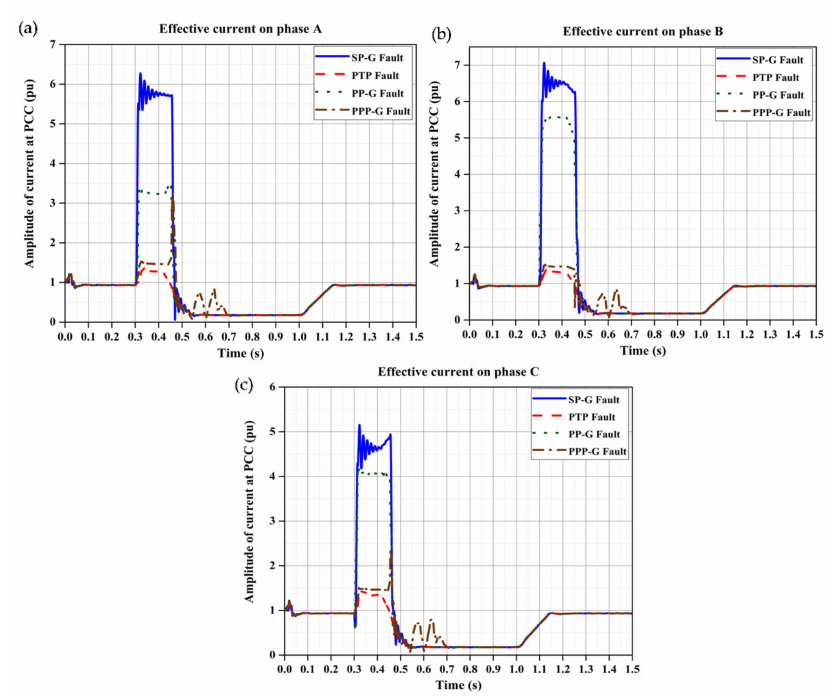
Figure 5. ( a – c ) The variations of e ff ective values of the PCC current during grid fault conditions in di ff erent